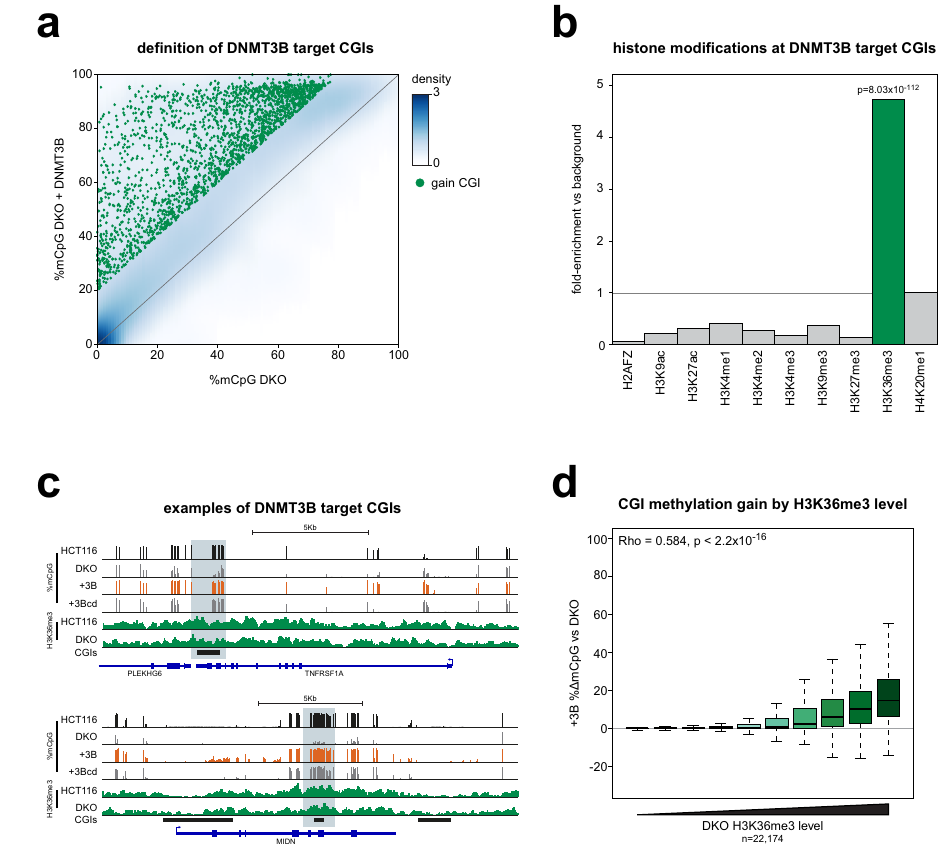
Fig. 2 DNMT3B methylates H3K36me3 marked CGIs in colorectal cancer cells. a Many CGIs gain methylation upon expression of DNMT3B in DKO cells. Density scatter plot comparing mean CGI methylation levels in DKO cells and DKO cells expressing DNMT3B (DKO + DNMT3B). Green individual points denote CGIs signi fi cantly gaining methylation upon DNMT3B expression ( ≥ 20% methylation gain and Benjamini – Hochberg corrected two-sided Fisher ’ s exact tests p < 0.05). b DNMT3B target CGIs are enriched in H3K36me3 marked regions. Barplot of the fold-enrichment observed for HCT116 histone modi fi cation peaks in the set of CGIs that signi fi cantly gain methylation when DNMT3B is expressed in DKO cells compared to the background of all CGIs observed in the experiment. P -values are from Fisher ’ s exact tests (1-sided for enrichment). c Examples of DNMT3B target CGIs. Genome browser plots showing DNA methylation levels with HCT116 and DKO H3K36me3 ChIP signal. CGIs and genes are shown below the plots. CGIs gaining methylation when DNMT3B is expressed in DKO cells are indicated in light blue. + 3B = DKO + DNMT3B; + 3Bcd = DKO + catalytically dead DNMT3B. Scale for methylation data is 0 to 100%. For H3K36me3 it is 0 to 0.24 normalised reads per 10 6 . d CGIs with the highest levels of H3K36me3 gain the greatest levels of DNA methylation. Boxplot showing gain of DNA methylation at CGIs when DNMT3B is expressed in DKO cells relative to their level of H3K36me3. CGIs were ranked by H3K36me3 level in DKO cells estimated from 2 biological replicates and split into 10 equally sized groups. Lines = median; box = 25th – 75th percentile; whiskers = 1.5 × interquartile range from box. Source data are provided as a Source Data fi